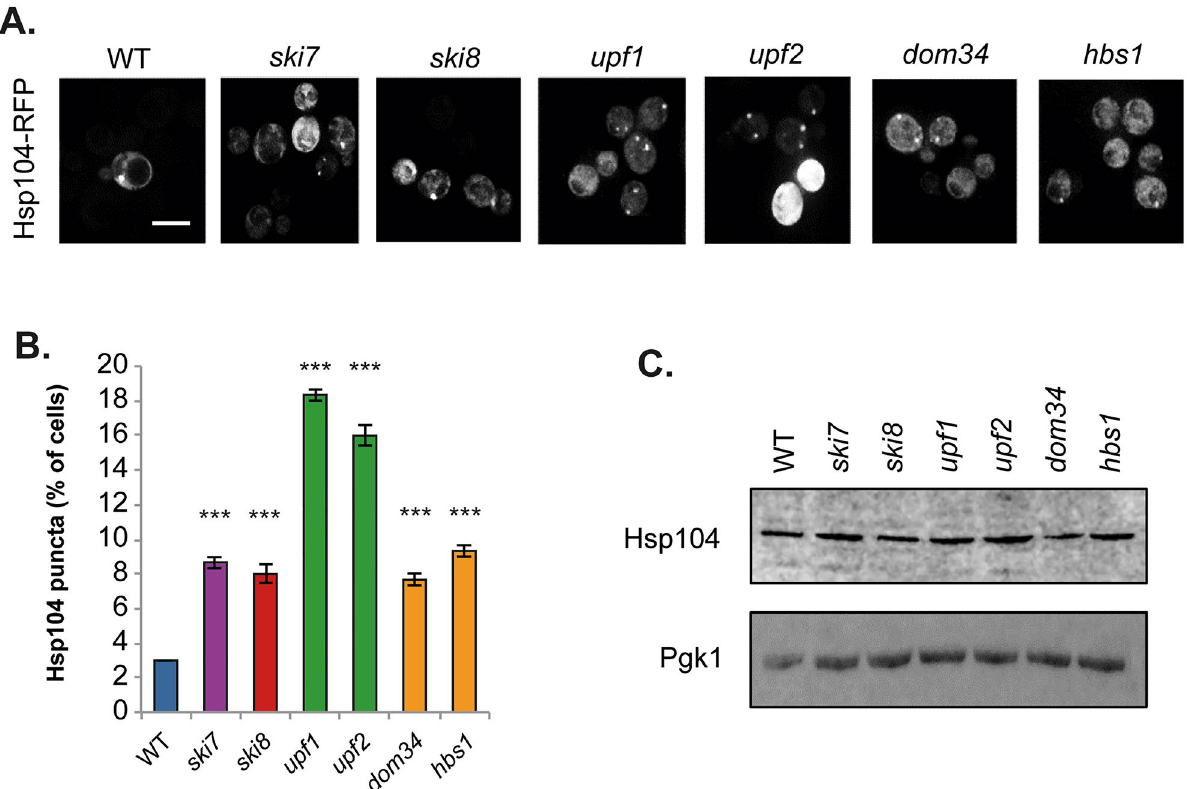
Figure 1. Strains lacking components of mRNA surveillance pathways have higher levels of protein aggregation. ( A ) Hsp104-RFP was visualized in wild-type and mutant strains disrupted for NGD ( dom34, hbs1 ), NMD ( upf1, upf2 ), NSD ( ski7 ) and the Ski complex ( ski8 ). Examples of cells containing visible puncta are shown. ( B ) The percentage of cells containing visible Hsp104-RFP puncta is quantified for each strain. Data shown are the means of three independent biological repeat experiments ± SD. Significance is shown compared with the wild-type strain; *** p < 0.001. ( C ) Western blot analysis of Hsp104 protein levels. Blots were probed with a Pgk1 antibody as a loading control. The full blots are shown in Supplementary Fig.